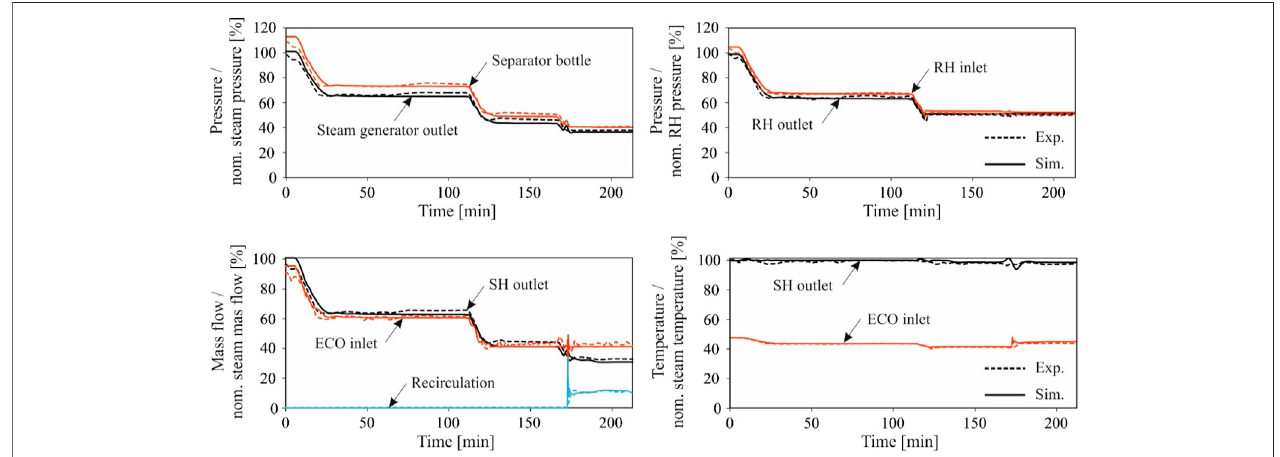
FIGURE 10 | Operational data and simulated results of the high-pressure and reheater circuits during load change scenario (source Starkloff et al.,